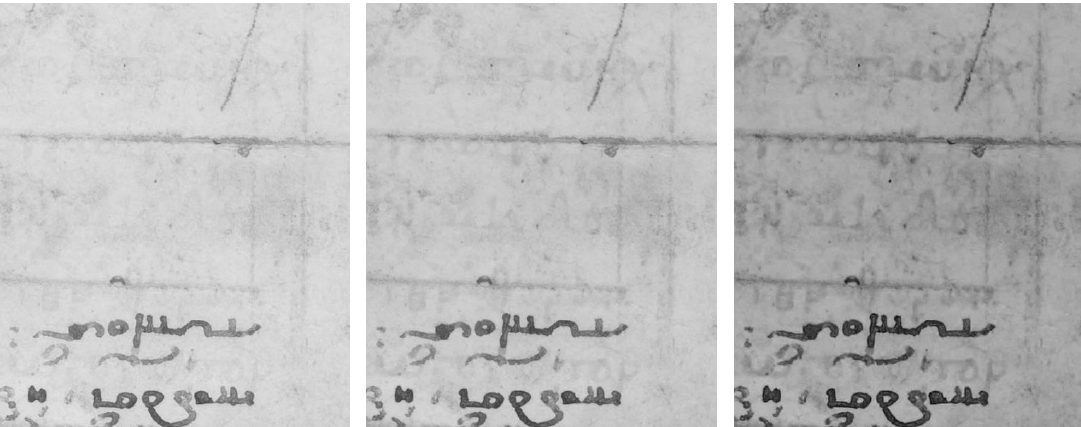
Figure 2. Trinity College Cambridge MS. O.9.27: detail of the Red, Green and Blue channels respectively, containing Mark 2:2. Used with permission from the Master and Fellows of Trinity College